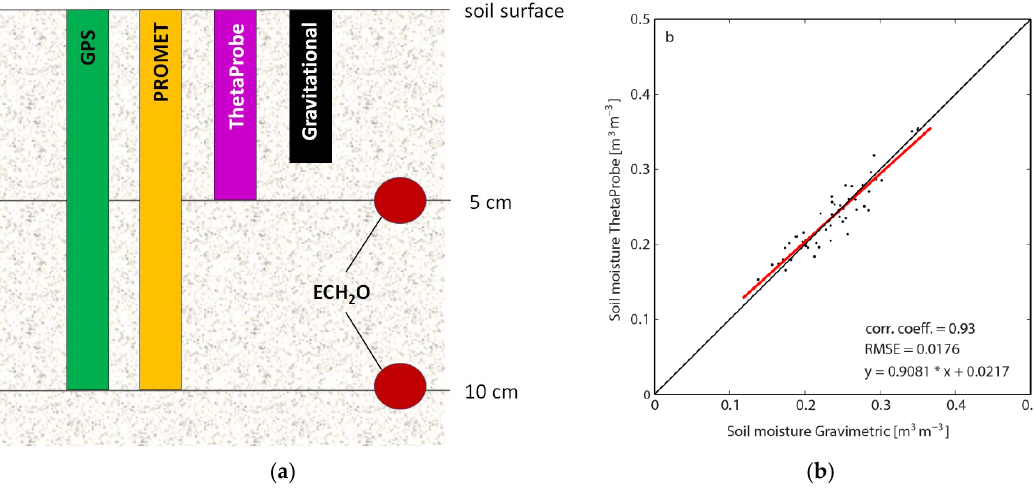
Figure 2. ( a ) Vertical location and measurement range in the soil column of the different methods to derive soil moisture; ( b ) Validation of ThetaProbe soil moisture readings by comparison with gravimetric measurements at the DWD test site in Munich during numerous field campaigns over the measurement period 1 January 2014–10 June 2015.